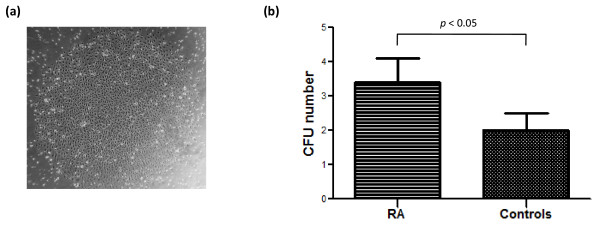
Late-outgrowth endothelial progenitor cell colony-forming unit (CFU) number in rheumatoid arthritis (RA) patients and controls. (a) Representative photomicrograph of late-outgrowth CFUs in culture after 15 days from one RA patient (×40 magnification). (b) Increase of CFU number in RA patients (P < 0.05).